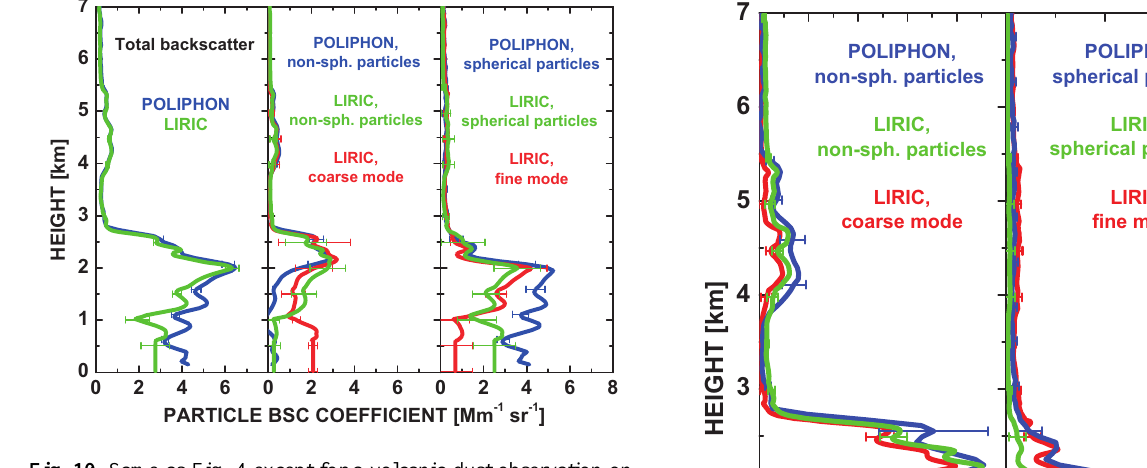
Fig. 13. Same as Figure 7, except for a volcanic dust observation on 19 April 2010. LIRIC profiles are derived from Figure 9 (green curves). Raman lidar observations (blue circles) were performed from 1330–1530 UTC. Raman lidar signals are smoothed with win- dow lengths of 660 m in the case of extinction coefficients and the lidar ratio.